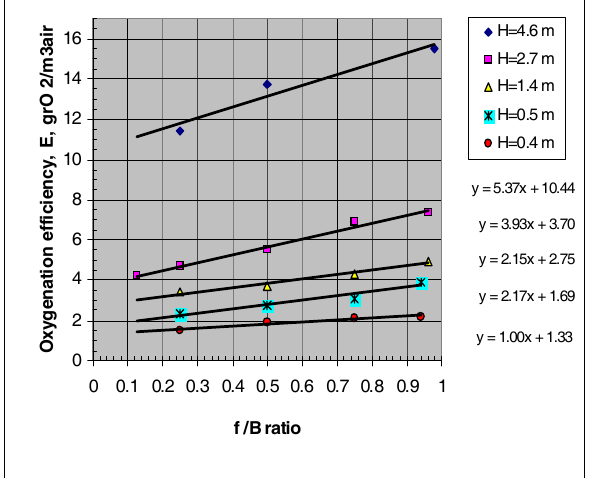
Figure 8: Effect of (f/B) ratio on oxygenation efficiency (E) of the system at constant air flow rate.